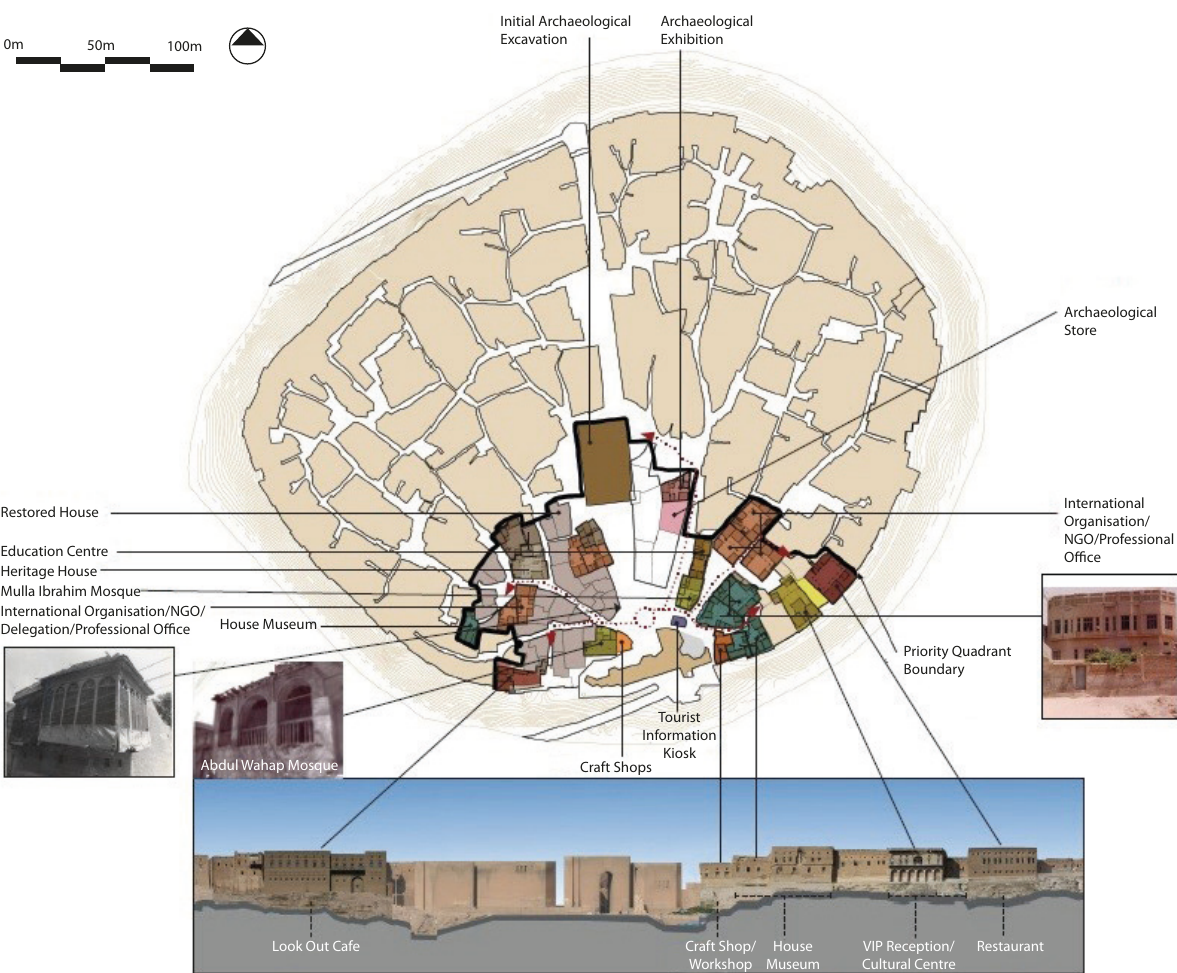
Figure 3 Priority quadrant land use proposal; which combines different cultural and recreational functions supporting the tourist goal of the site in the; maintained architectural elements, but cancelled residential functions (Source: Huszar